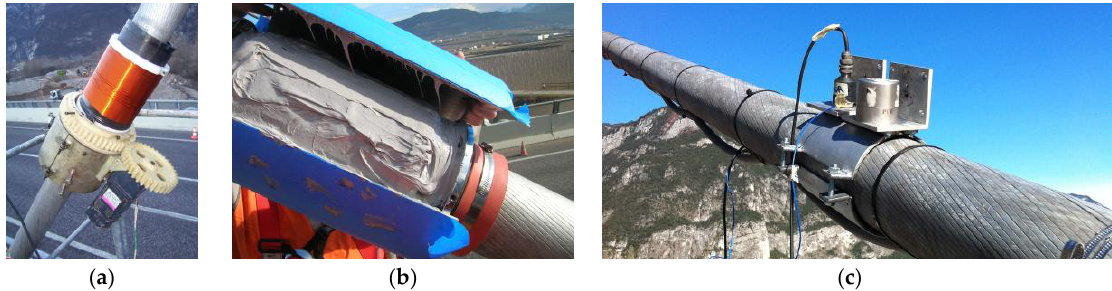
Figure 5. ( a ) Primary and secondary coil of EM sensors are wound around cables; ( b ) the two coils are protected by epoxy covers; ( c ) installation of accelerometers for in situ